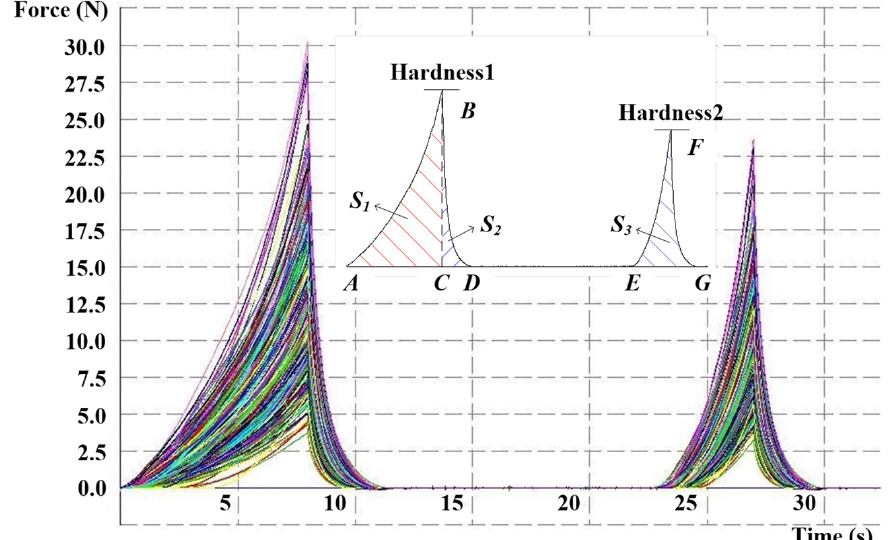
Figure 4. Force–time curve of secondary compression tests for root lumps of tomato seedlings raised in different substrates: line A - B - D is the first loading and unloading force–time curve; line E - F - G is the second loading and unloading force–time curve; S 1 is the area bounded by the force–time curve of line A - B - C ; N.s; S 2 is the area bounded by the force–time curve of line C - B - D , N.s; S 3 is the area bounded by the force–time curve of line E-F-G , N.s; the cohesiveness is the ratio of the energy done by the second compression to the first, which is calculated by S 3 /( S 1 + S 2 ); The resilience is the ratio of the energy done by the first unloading compression to the loading, which is calculated by S 2 / S 1 .